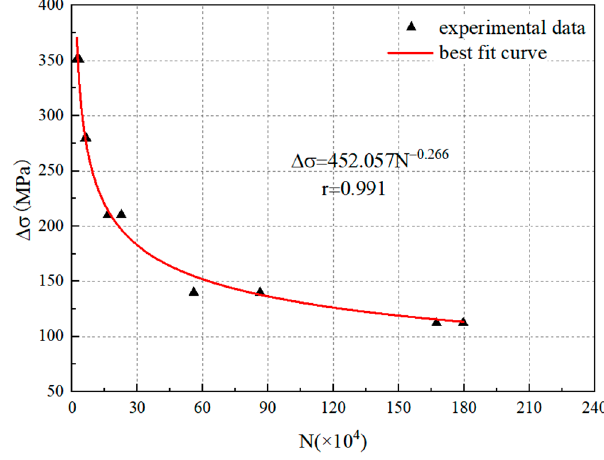
Figure 6. Power regression curve of M20 torque ‐ shear HSBs.